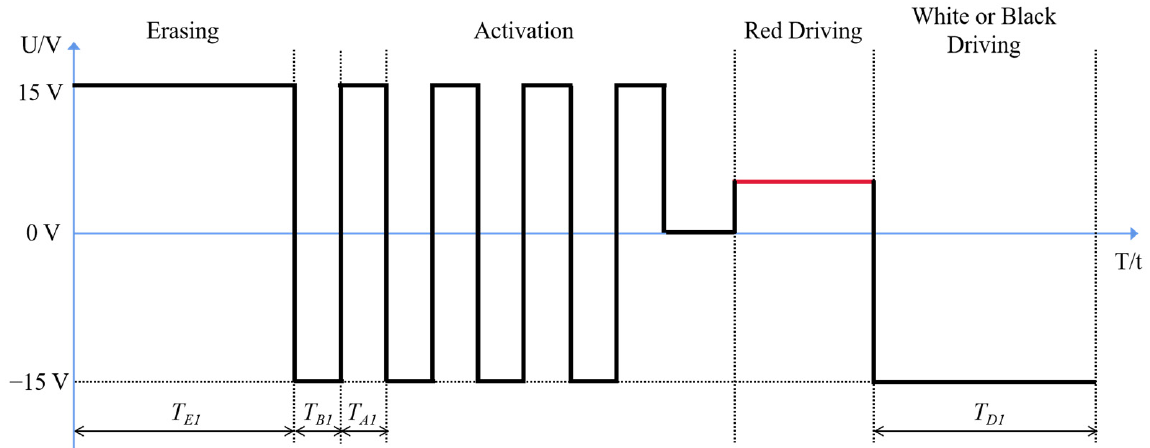
Figure 3. The traditional driving waveform of three-color EPDs. It consisted of an erasing stage, an activation stage, a red driving stage, and a white or a black driving stage. T E 1 is the duration of the erasing stage. T B 1 is the duration of negative voltage in one oscillation cycle, and T A 1 is the duration of positive voltage in one oscillation cycle. T D 1 is the duration of the white or black driving stage.